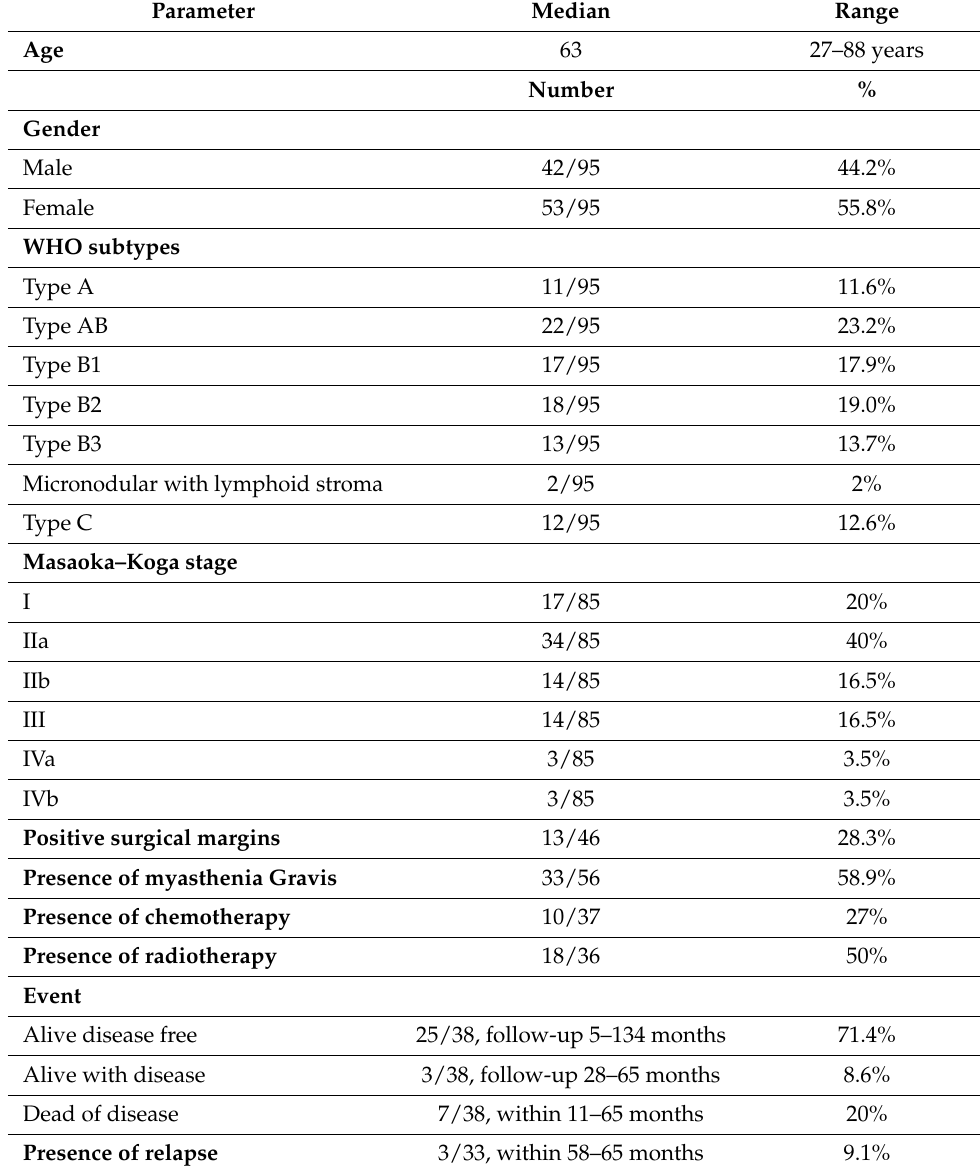
Table 2. Clinicopathological characteristics of 95 patients with